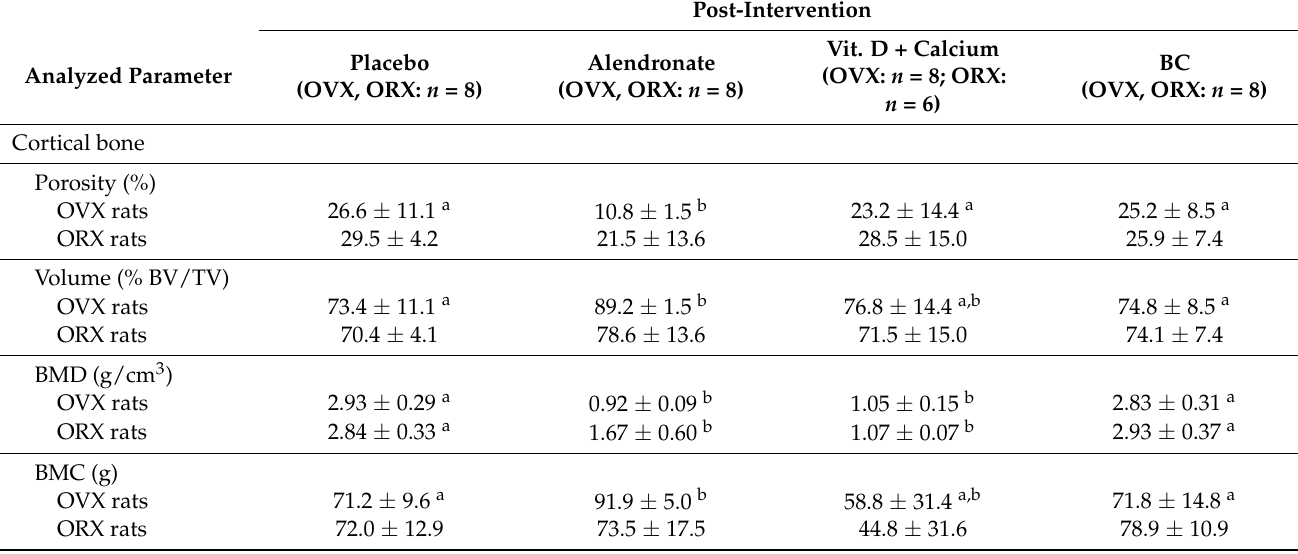
Table 1. Post-supplementation bone microarchitecture results of the placebo, alendronate, vitamin D and calcium and BC supplementation groups–OVX and ORX